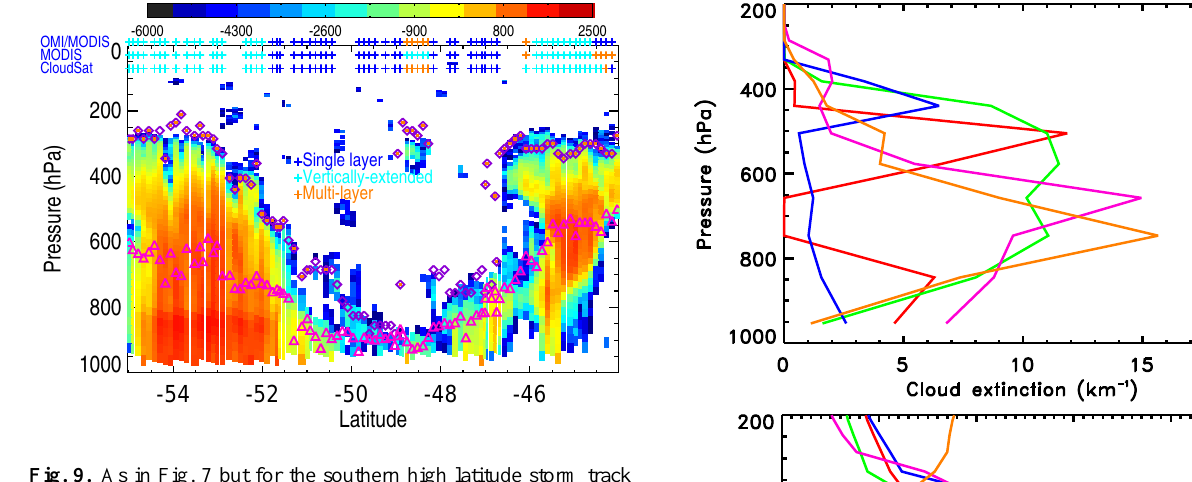
Fig. 9. As in Fig. 7 but for the southern high latitude storm track along OMI orbit 12402 (western and southernmost track high- lighted in Fig. 6).